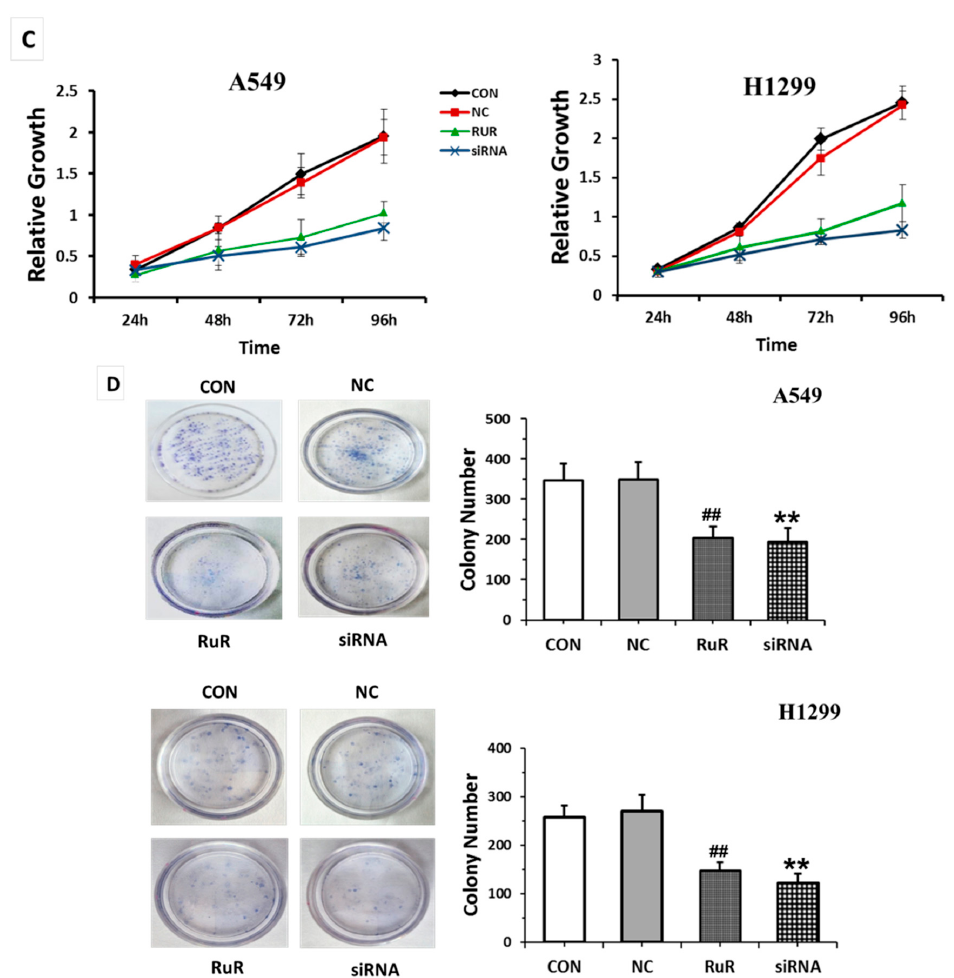
Figure 3. The effect of TRPV3 on lung cancer cell proliferation. The effect of RuR (1–40 μ M) on A549 and H1299 cells after 24 h was analyzed by MTT ( A ); data are expressed as mean ± SD of